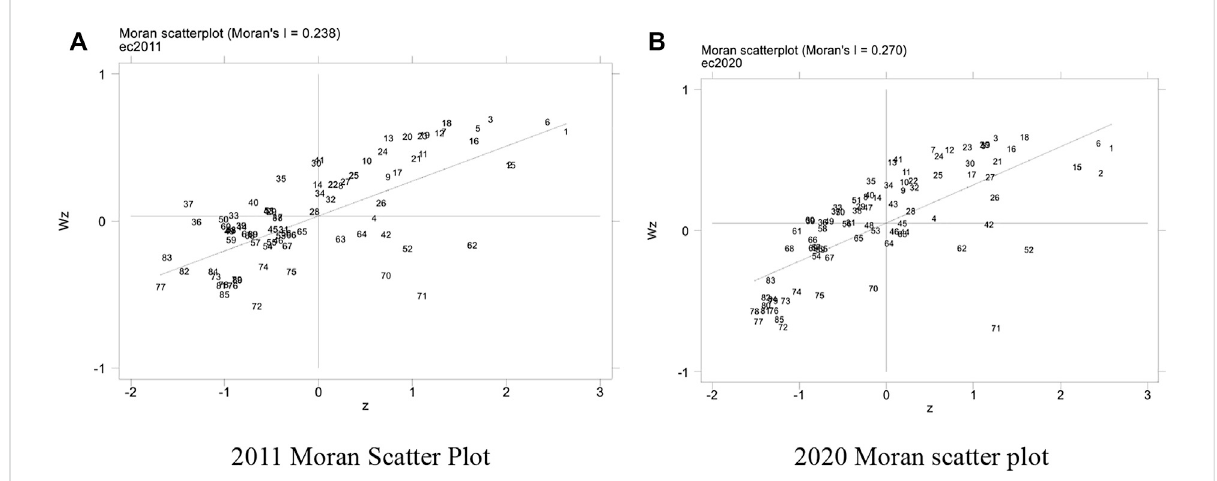
FIGURE 7 Moranscatterdiagramofthehigh-qualityeconomicdevelopmentofthethreemajorurbanagglomerationsintheYangtzeRiverEconomicBelt. (A) 2011 Moran Scatter Plot (B) 2020 Moran scatter